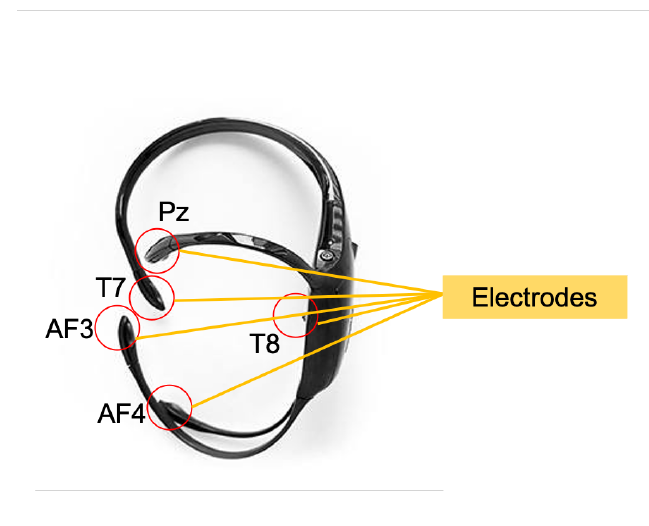
Figure 3. The Emotiv headset with five electrodes marked at positions AF 3, AF 4, T 7, T 8, andPz